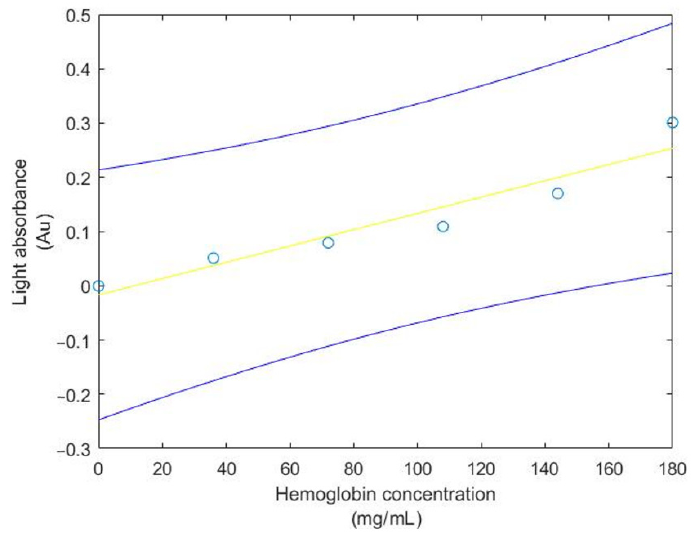
Figure 9. The 95% confidence interval for an additional observation of light absorbance from the MAX30100 sensor at given Hb concentration.